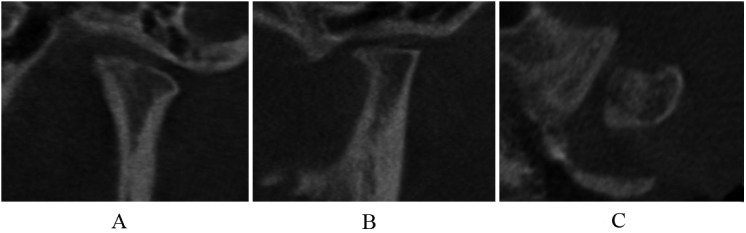
Osteophyte and short condyles in coronal (A), sagittal (B), and axial (C) images.